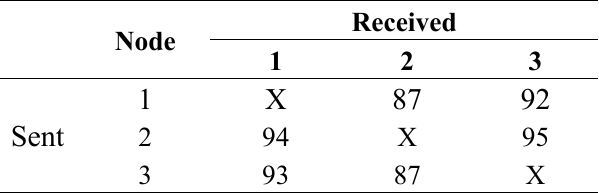
Table 5. Node percentage in the static test.